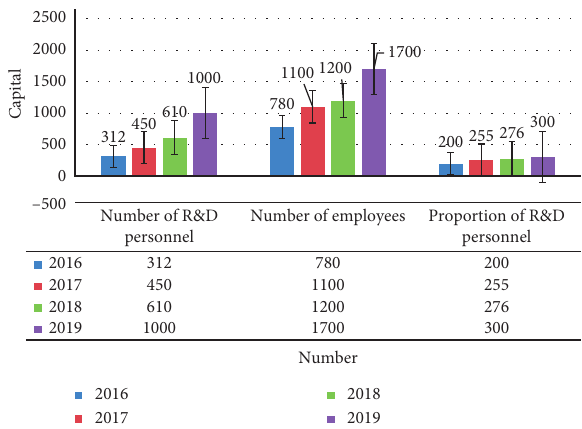
Figure 11: Human capital structure of X software company in